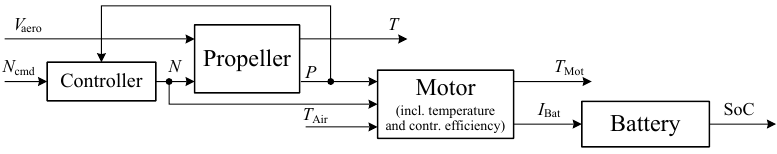
Figure 5. Overview of propulsion components